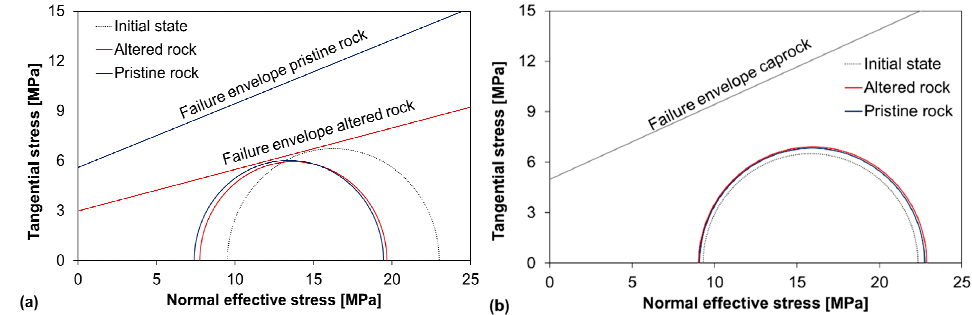
Figure 9. Mohr’s circles 50 m away from the injection well ( a ) in the middle of the reservoir and ( b ) 10 m above the reservoir-caprock interface, showing the initial stress of state and the resulting stress of state after 3 years of injection when considering (altered rock) and not considering (pristine rock) changes in the reservoir properties as a result of geochemical